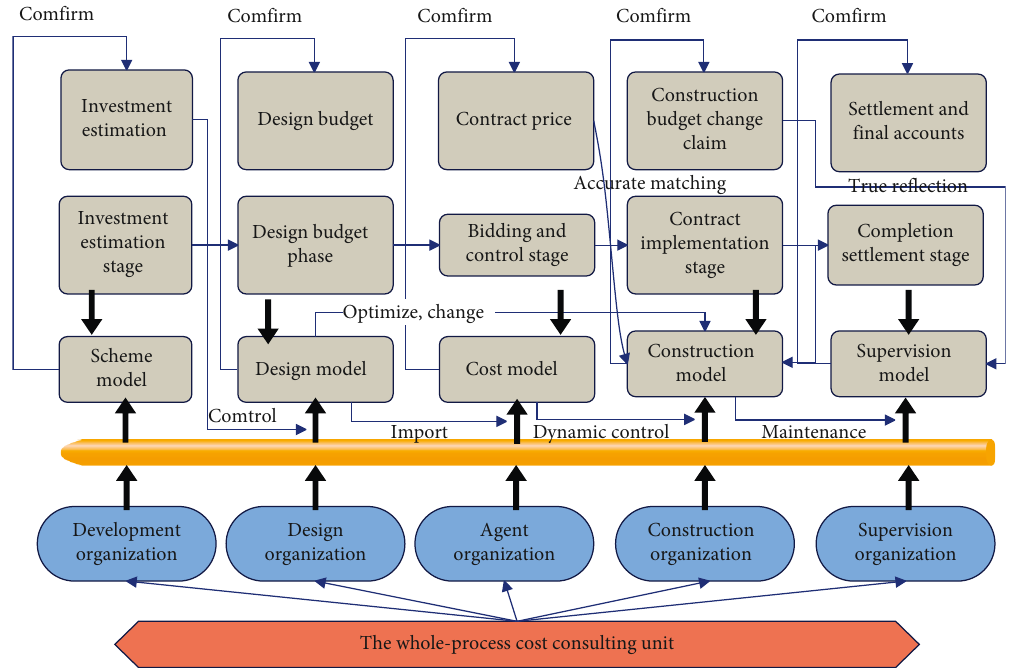
Figure 14: The whole-process cost consulting information management environment based on BIM